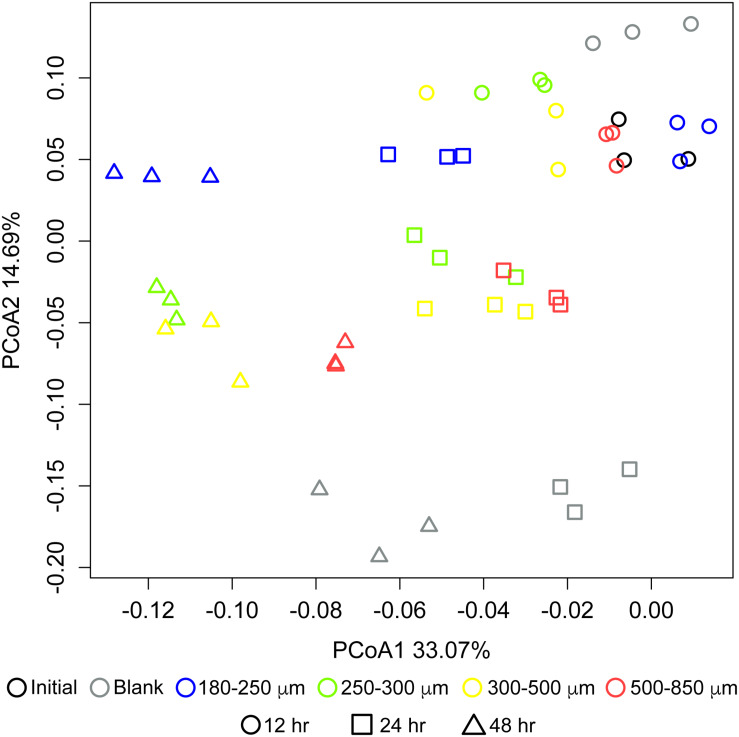
Differences in microbial community structure between maize bran-fermenting fecal microbiota from three healthy donors. Principal component analysis (PCoA) of communities fermenting different maize bran size fractions were determined by 16S rRNA amplicon sequencing, and β-diversity metrics were based upon Bray–Curtis dissimilarity calculated using from OTU relative abundances after 12, 24, and 48 h of in vitro fermentation. Initial represents the fecal community in the inoculum. Blank represents a no-carbon control.